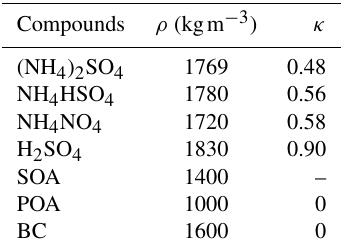
Table 1. Gravimetric densities ( ρ ) and hygroscopicity parameters ( κ ) for each component used in the ZSR